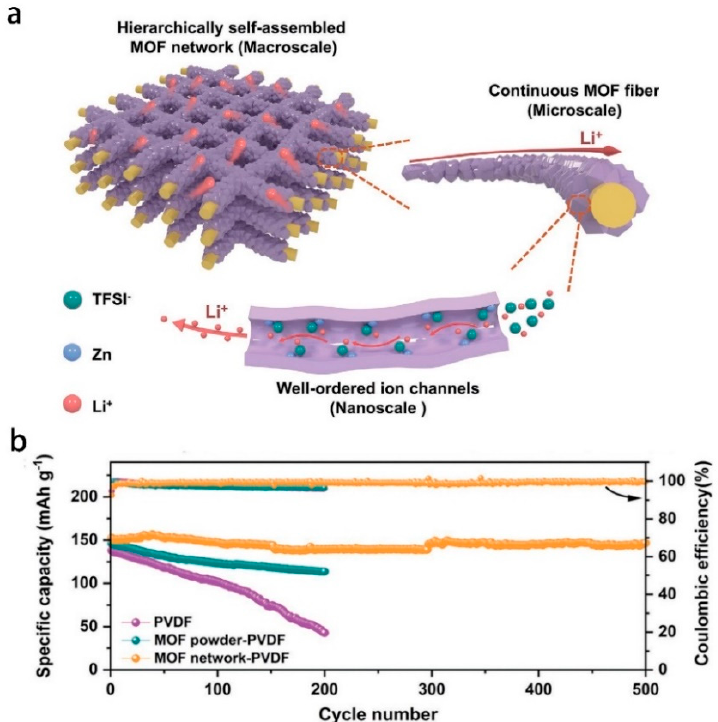
Figure 2. ( a ) Schematic illustration of hierarchically self − assembled MOF network as 3D ion conductor with continuous Li + transport. ( b ) Cycling performances with different solid electrolytes. Adapted with permission from ref. [125]. Copyright 2022 John Wiley and Sons.